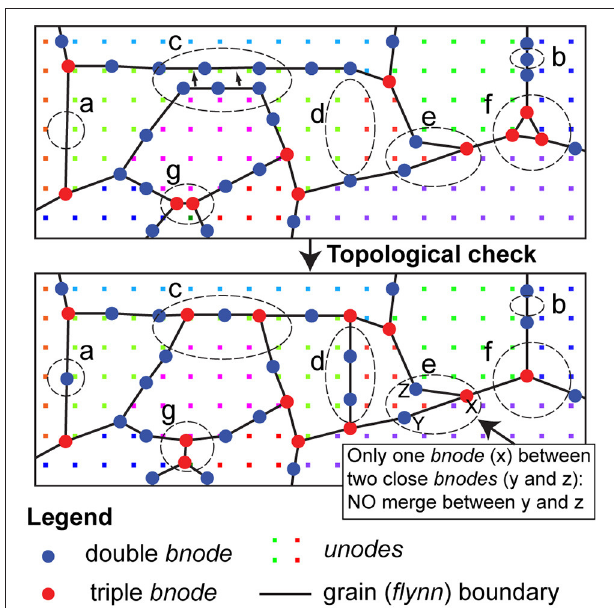
FIGURE 2 | Microstructure discretisation and topological events necessary if bnodes move due to deformation or grain boundary migration. Insertion (a) and deletion (b) of a bnode to keep a constant resolution (c) Merging two non-neighboring bnodes , this numerically defines grain dissection (d) Insertion of new grain boundary by polygonisation between unode clusters above a critical misorientation (e) No merging of two non-neighboring bnodes as number of other bnodes between the two close bnodes is < 3 (f) Deletion of small flynn containing no unodes (g) Neighbor switch in triple bnodes